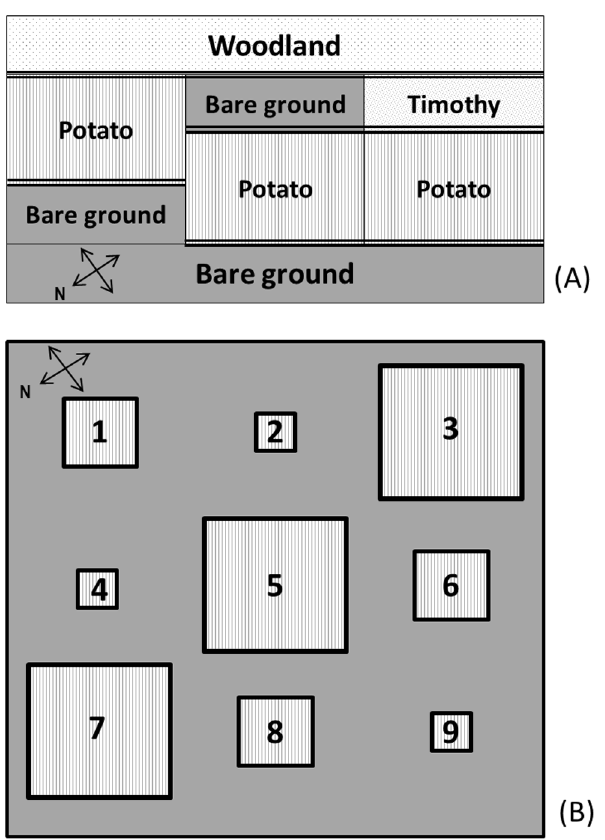
Figure 1. Diagrammatic representation of field plots in 2011 (A) and 2012 (B). Mixed borders are represented by = = = = in (A). In 2012, plots 2, 4, 9 were 4 6 4 m, 1, 6, 8 were 8 6 8 m and 3, 5, 7 were 16 6 16 m (see also Table